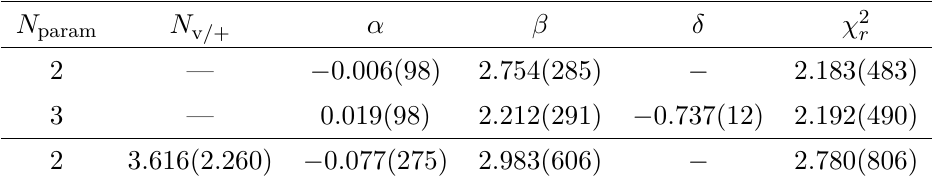
Table 2. Unpolarized nucleon valence and plus quark PDF parameters obtained from performing uncorrelated cosine/sine transform fits to the real/imaginary component of the matched ITD at 2 GeV in MS. Results for the plus quark PDF are only shown for N polynomial P ( x ) = 1 , as higher numbers of parameters led to uncontrolled fits. The uncorrelated figure of merit is also